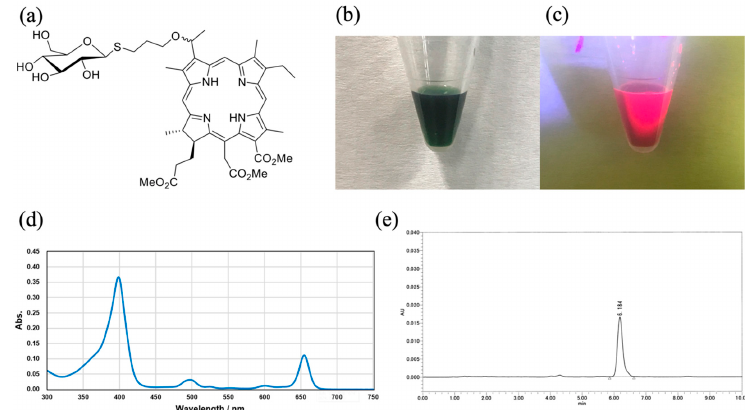
Figure 1. Glucose-conjugated chlorin e6 (G-Ce6). ( a ) Chemical structure of G-Ce6. Methyl (7S,8S)-18-ethyl-5-(2-methoxy-2-oxoethyl)-7-(3-methoxy-3-oxopropyl)-2,8,12,17-tetramethyl-13-(1-(3-(((2S,3R,4S,5S,6R)-3,4,5-trihydroxy-6-(hydroxymethyl) tetrahydro-2H-pyran-2-yl) thio) propoxy) ethyl)-7H,8H-porphyrin-3-carboxylate (G-Ce6). ( b ) White light image of 2 mg/mL G-Ce6 solution (20% Tween 80 in phosphate buffered saline). ( c ) Fluorescence image of 2 mg/mL G-Ce6 (excitation, 405 nm). ( d ) UV-vis spectrum for G-Ce6 in DMSO (3 × 10 − 6 M). ( e ) HPLC spectrum for G-Ce6. Column: Kinetex XB-C18 (2.6 µ m (particle size), 4.6 mm (internal diameter), 75 mm (length), Phenomenex), 10 mmol / L ammonium acetate / acetonitrile (35:65, v / v ) as solvent, and UV detector at 254 nm were